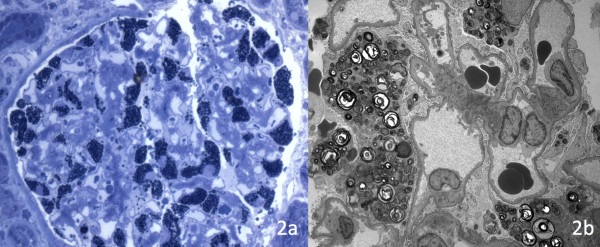
Histological sections showing: a) toluidine blue staining demonstrating abundant deposition of glycolipid inclusions within the podocytes and; b) electron microscopy with ‘zebra’ bodies - enlarged secondary lysosomes packed with lamellated membrane structures.